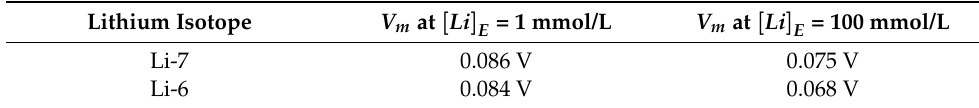
Table 30. The table shows the membrane potential values at extracellular lithium concentration of 1 mmol/L and 100 mmol/L and based on the quantum transport and the corresponding setting values as in graph (c) of Figure 10.